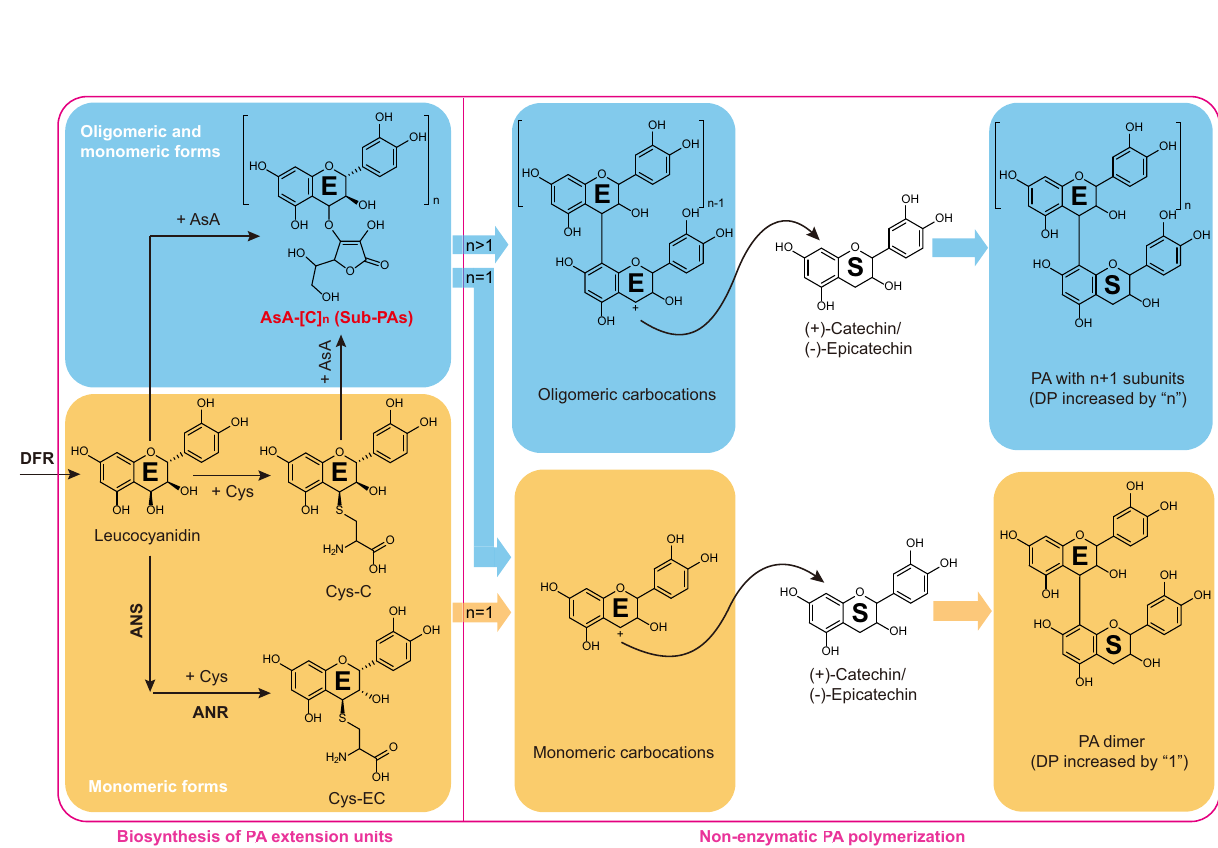
Fig. 10 An updated model for PA polymerization. PA extension units are denoted as “ E ” and PA starter units are denoted as “ S ” . The arrows without enzymes indicate the non-enzymatic pathway. Cys, cysteine; AsA, ascorbate. DP, degree of